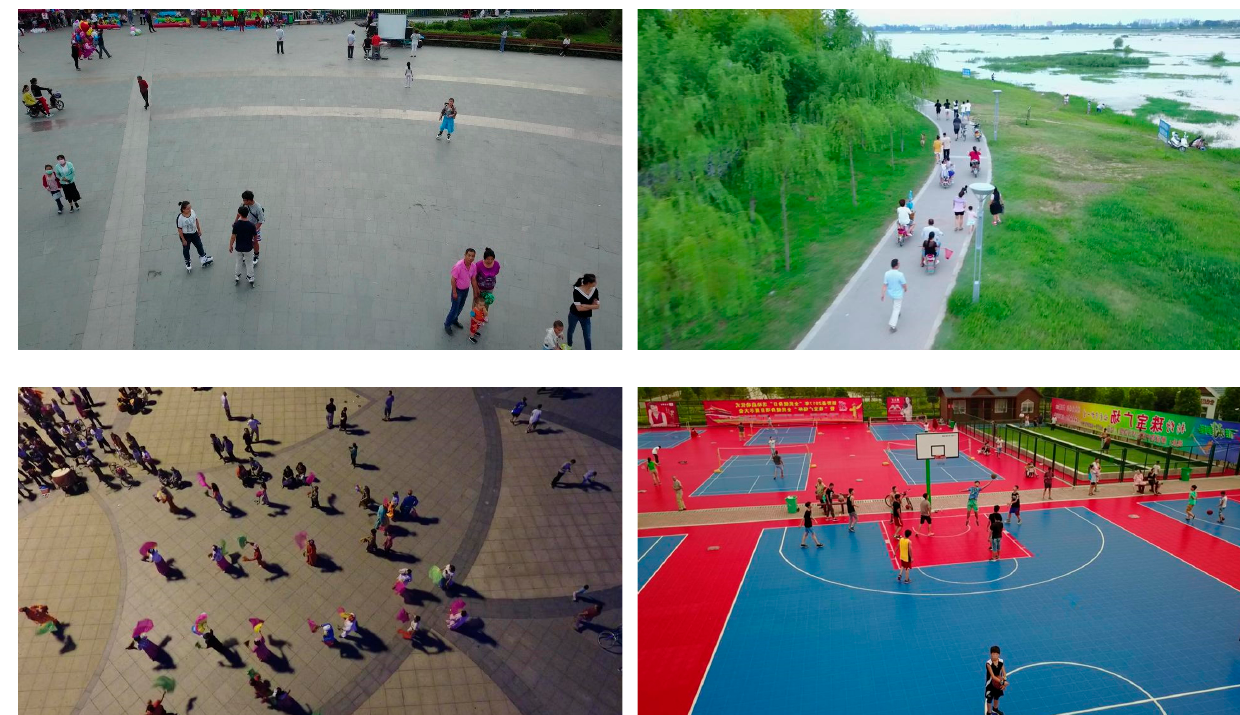
Figure 4. Images of pedestrian feature-rich images in VisDrone dataset.